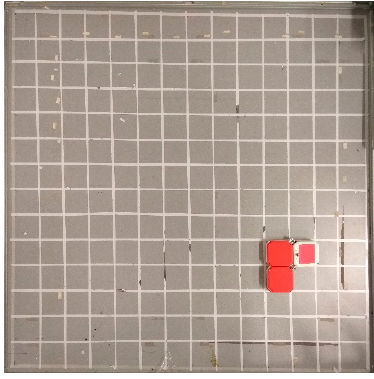
Figure 14. Defined test area with segmented square grids.